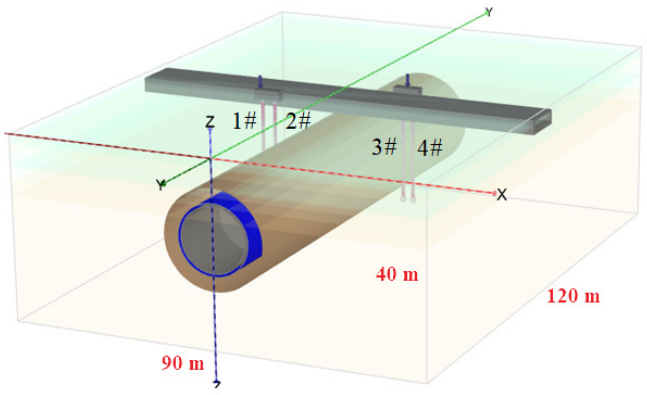
Figure 7. PLAXIS 3D finite element model. Table 2. Physical and mechanical parameters of the soil